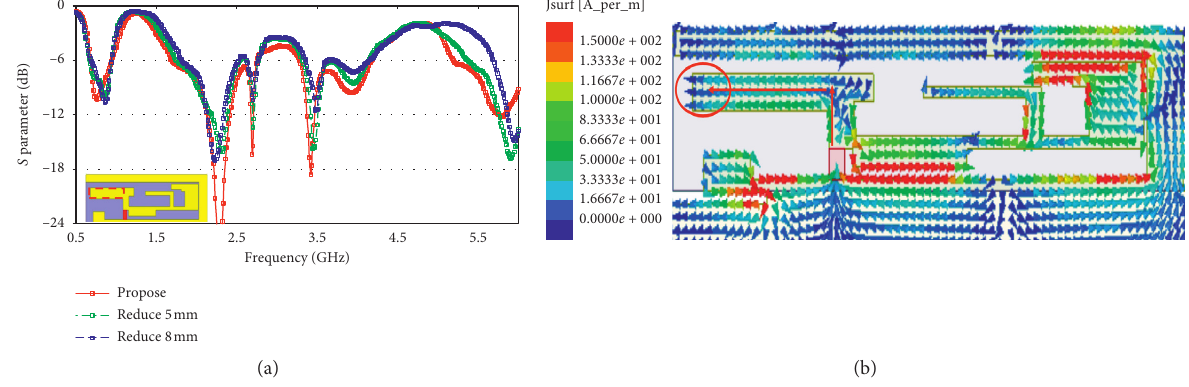
Figure 6: (a) S 11 values derived from simulation considering various lengths of the left-side direct-fed arm for the developed antenna; (b) left-side arm’s current distribution at 5.5